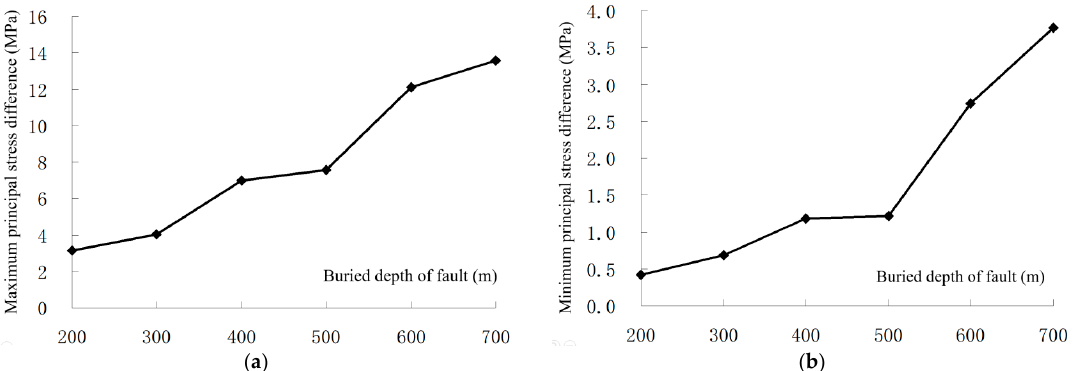
Figure 12. The distribution of stress difference between the hanging wall and footwall of surround- ing rock on the monitoring line under different upper boundary burial depths of fault, they should be listed as: ( a ) Maximum principal stress difference; ( b ) Minimum principal stress difference.